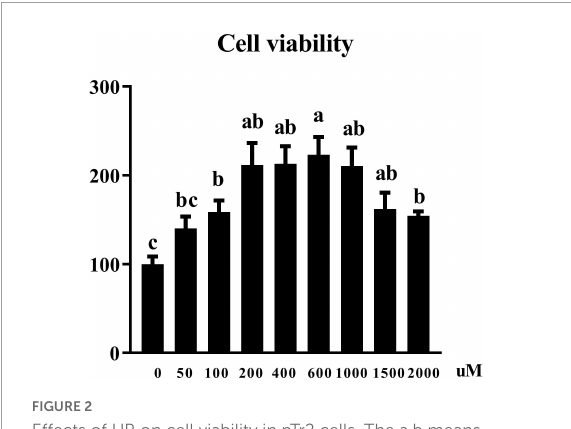
FIGURE2 Effects of UR on cell viability in pTr2 cells. The a,b means columns with different letters are significantly different ( P < 0.05), and columns with the same letters or no superscript are considered when P > 0.05. n = 6 replicates.